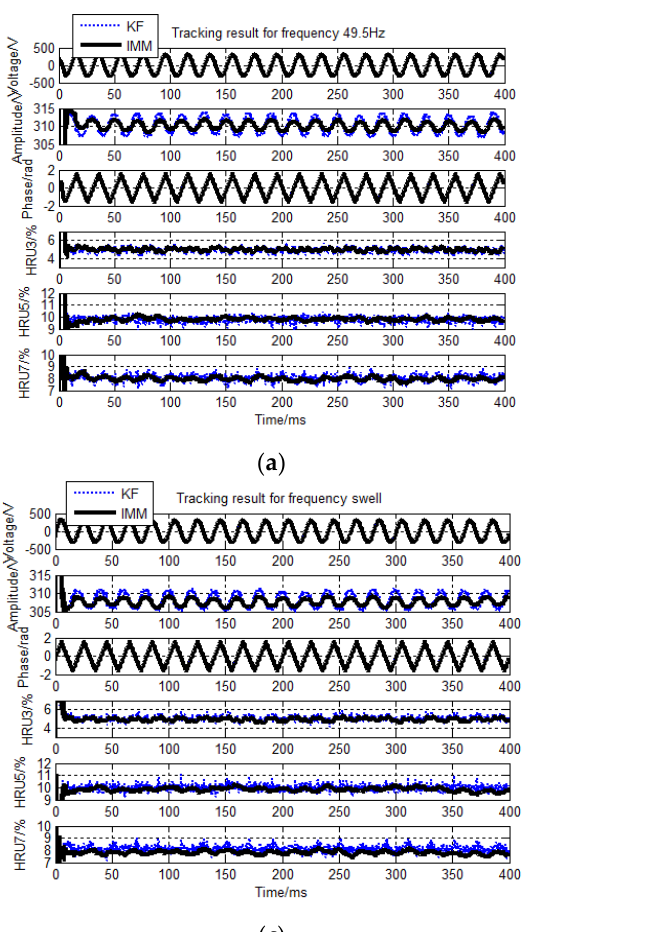
Figure 14. Experiment tracking results for voltage frequency heavy fluctuations. ( a ) Experiment tracking results for fre- quency 49.5 Hz; ( b ) Experiment tracking results for frequency 50.5 Hz; ( c ) Experiment tracking results for frequency swell; ( d ) Experiment tracking results for frequency sag.